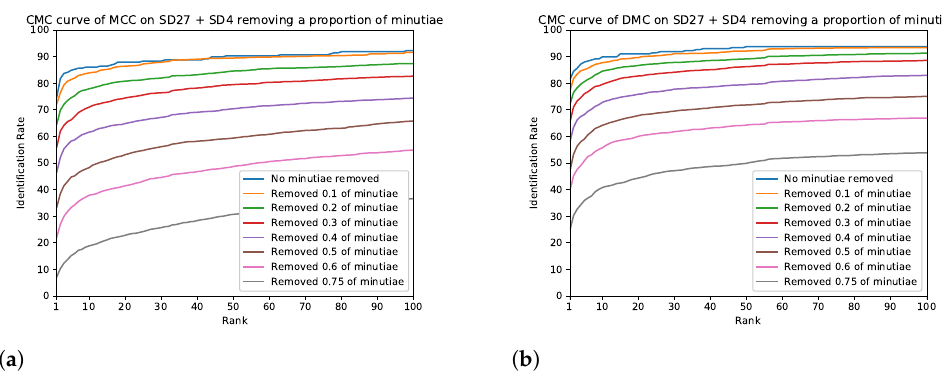
Figure 7. CMC curves for random proportion removal of minutiae using both MCC and DMC as matching algorithms. ( a ) CMC curves for random proportion removal of minutiae using MCC as matching algorithm. ( b ) CMC curves for random proportion removal of minutiae using DMC as matching